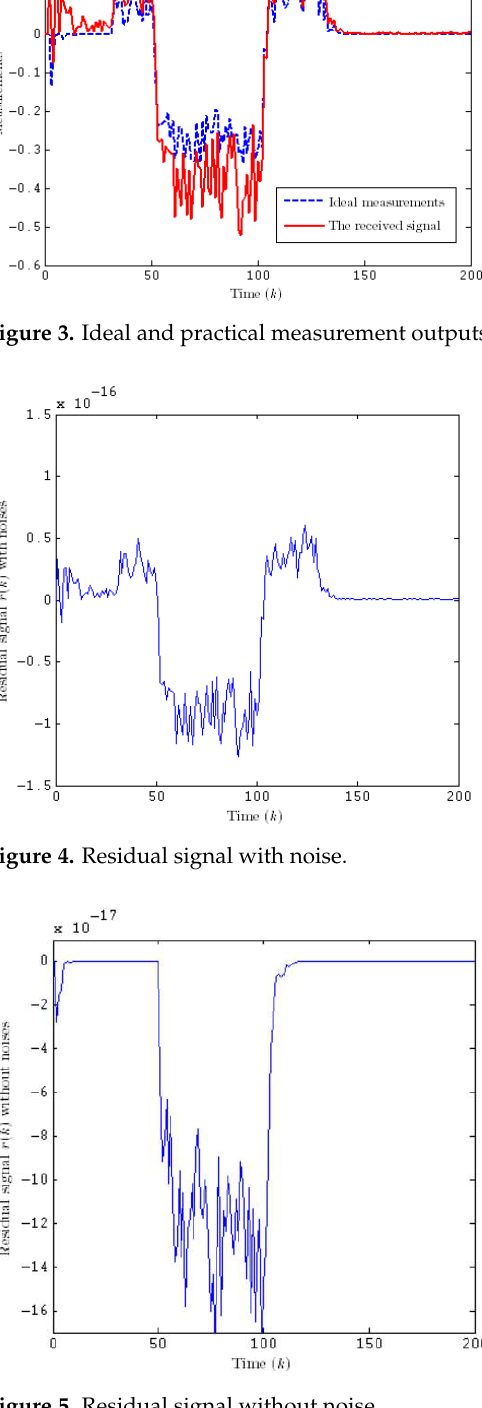
Figure 6. Residual evaluation function with noises. Figure 7. Residual evaluation function without noises. 6. Conclusions